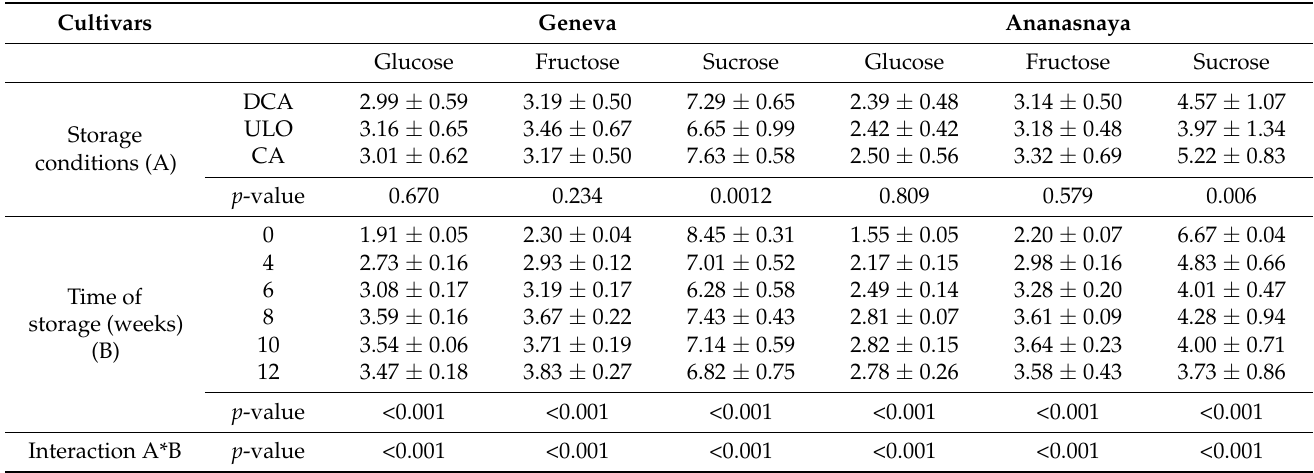
Table 4. Changes in monosaccharide and sucrose contents (g · 100 g − 1 F.W.) measured in ‘Geneva’ and ‘Ananasnaya’ minikiwi fruit in the postharvest period in 2017.